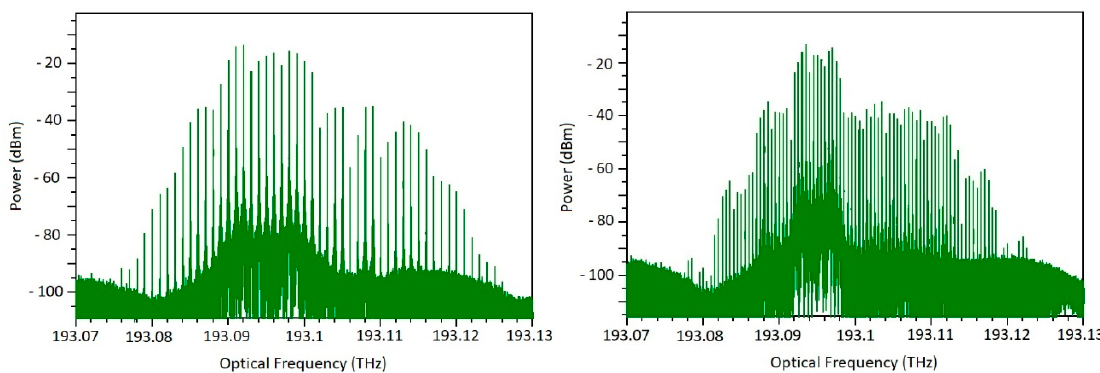
Figure 8. Optical comb after frequency shift. Resolution tuning capability. Left : 1 GHz Frequency spacing. Right : 500 MHz frequency spacing. Density of the of the comb is varied for increased resolution in the interrogation of a spectrometer.